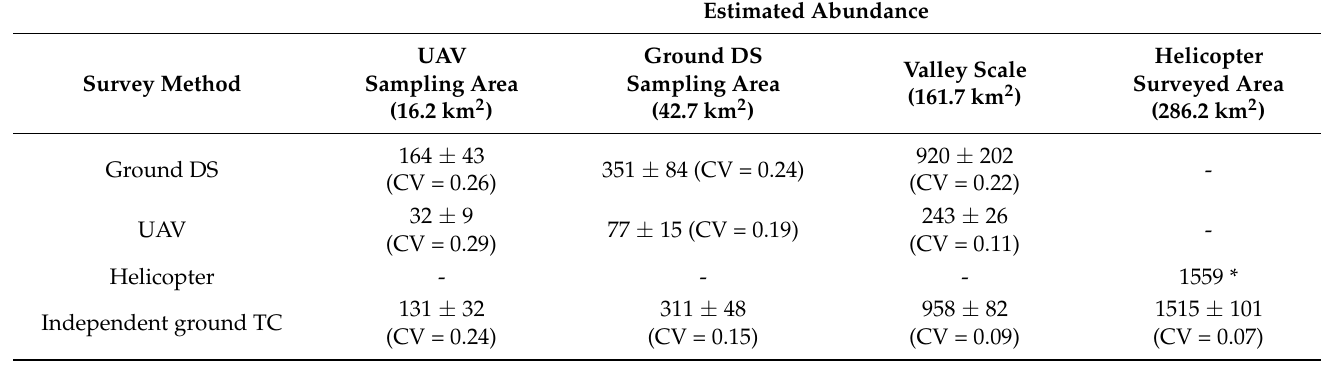
Table 1. Estimated Svalbard reindeer abundance ± SE in Sassendalen from density spatial models. Predicted abundance for each density model at three scales; Ground distance sampling (DS) scale (area covered by ground DS), UAV scale (area covered by UAV), the valley scale (ecologically relevant management area), and helicopter scale (area covered by helicopter). See Figure 1 for delineation of study areas. Coefficient of variations (CV) are in parentheses. Because the habitat characteristics and elevation ranges were different for the helicopter surveyed area (0.6–601 m) than for the ground and UAV transect area (0.7–317 m), we did not predict the ground DS and UAV density models to the helicopter surveyed area.